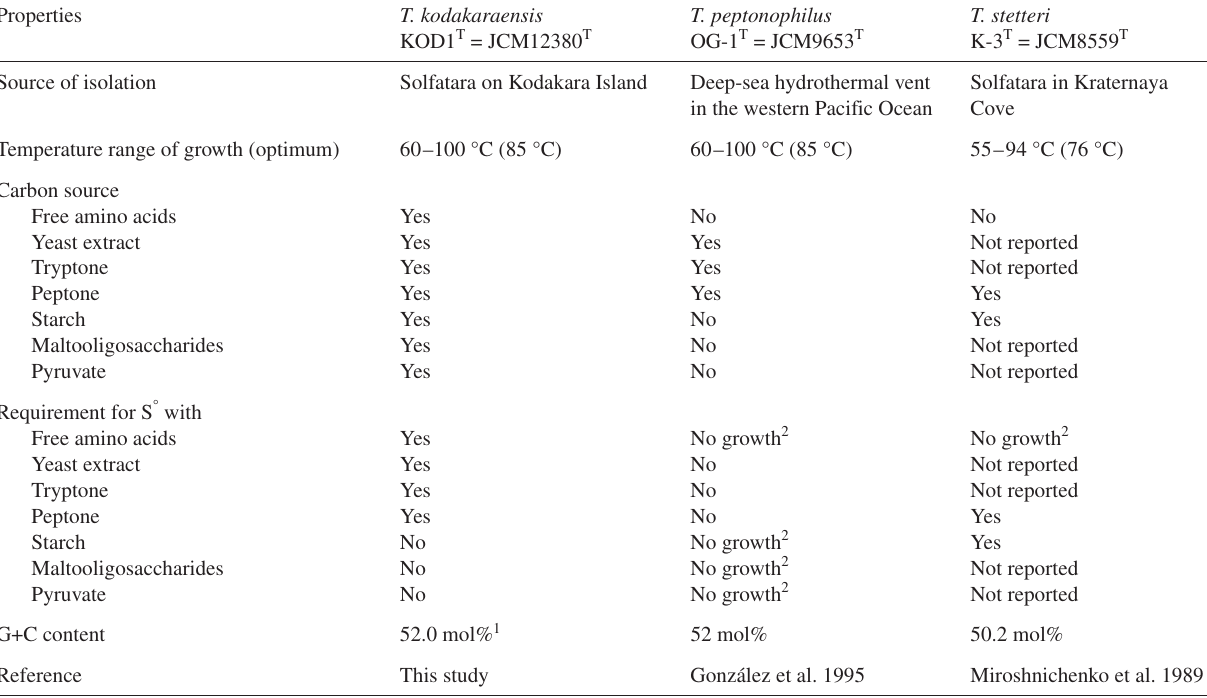
Table 1. Comparison of some properties among Thermococcus kodakaraensis , T. peptonophilus and T. stetteri .